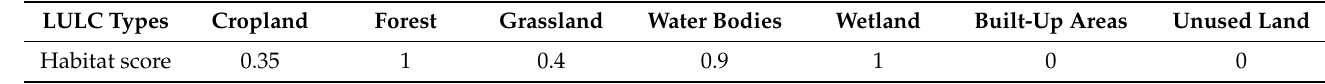
Table 4. Habitat suitability of each land use/land cover (LULC)